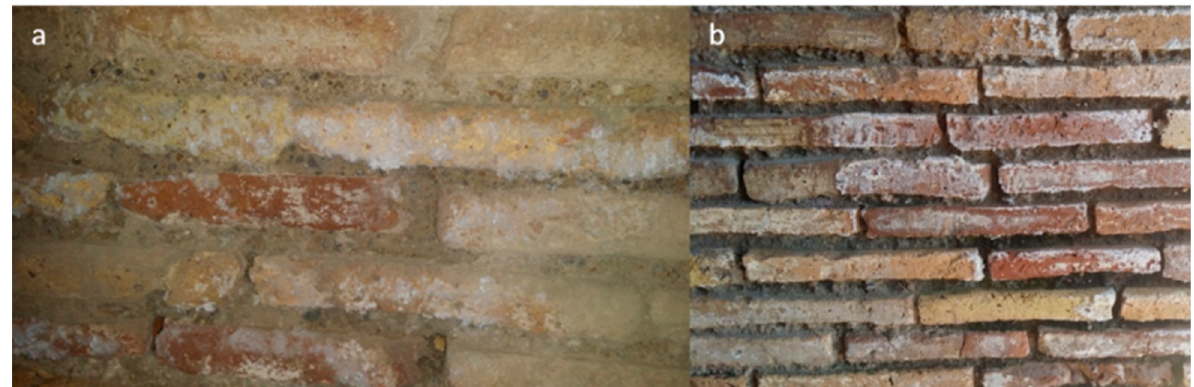
Figure 3. Examples of the soluble salts’ formation on walls. ( a ) The mattifying veil and the efflorescences on south wall of the pre-Mithraeum (indoors). ( b ) The opacifying and the efflorescences on south wall of the Triclinium (outdoors).